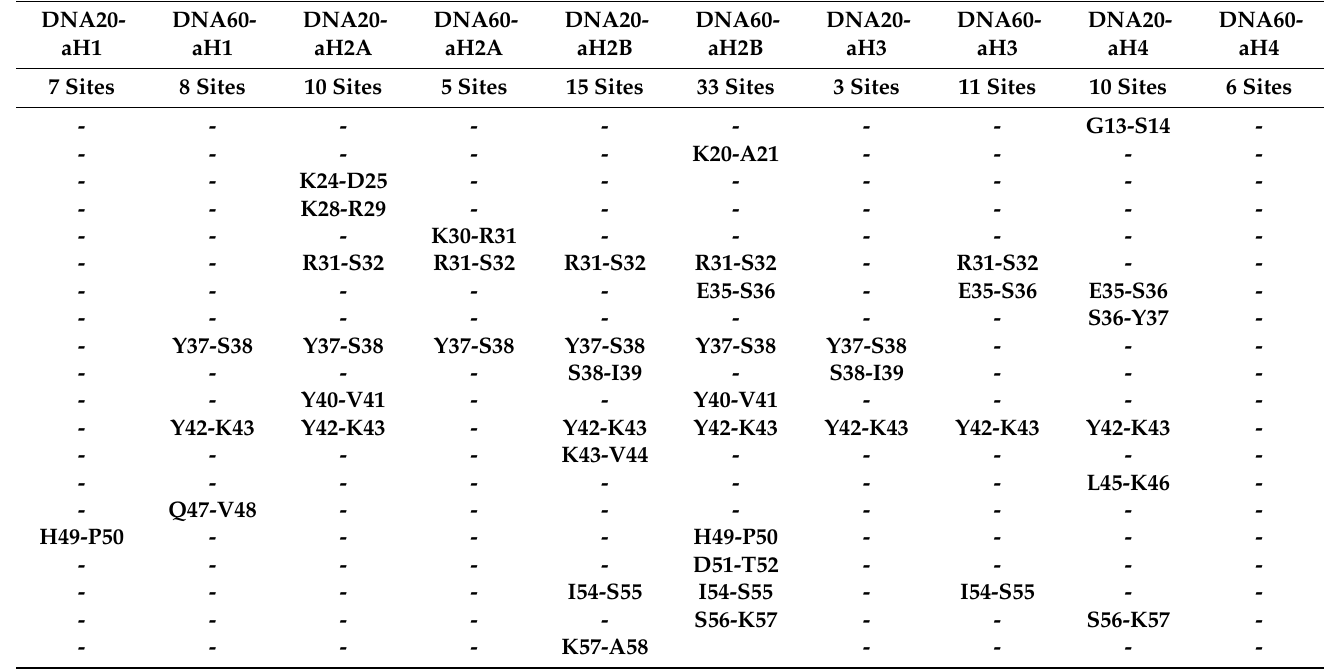
Table 4. Sites of H2B histone hydrolysis by IgGs against five individual histones 20 and 60 days after mouse immunization with DNA-histone complex